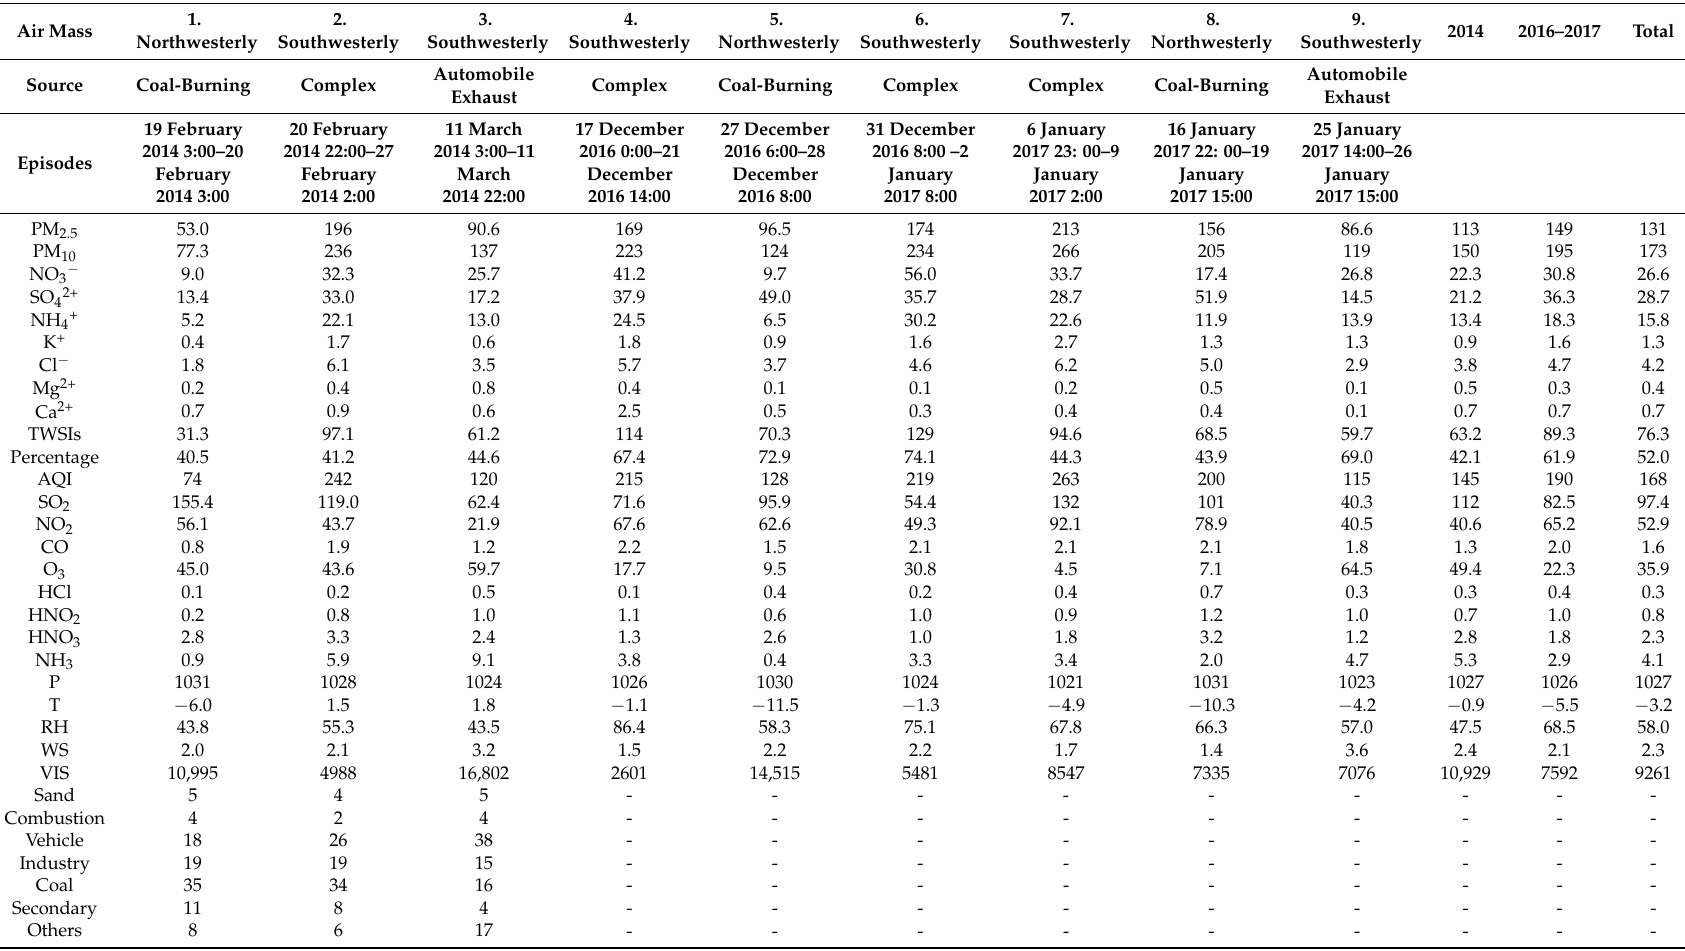
Table 2. Summary of mass concentrations of PM 10 and PM 2.5 and their water-soluble ion ( µ g · m − 3 ), gaseous pollutants ( µ g · m − 3 ; mg · m − 3 for CO), and meteorological parameters during the nine pollution episodes (year of 2014, 2016–2017) and the entire study period, as well as source apportionment fraction (%) based on SPAMS for the 2014 study